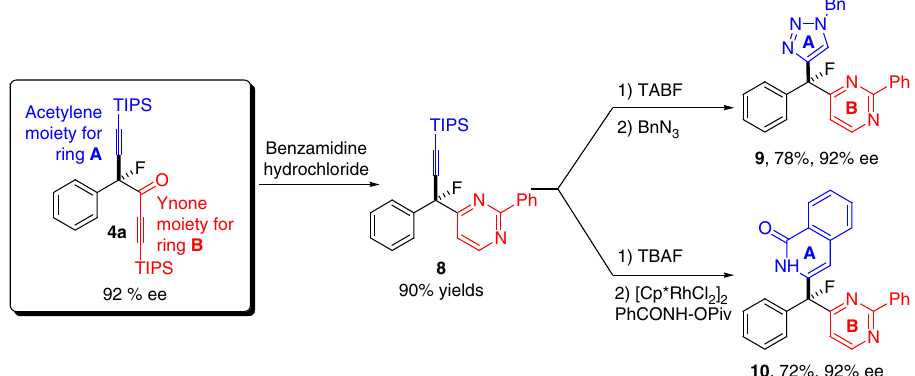
Fig. 2 Synthetic application of the α -alkynylation – α - fl uoro ynone products. Product 8 was obtained by re fl uxing 4a with benzamidine hydrochloride (1.2 eq.) in THF/water (7/1) for 16 h. Selective desilylation of 8 was accomplished using tert-butylammonium fl uoride (TBAF) in THF at 0 °C. Product 9 was obtained by click chemistry using benzyl azide and CuSO 4 and sodium ascorbate in EtOH and water. Product 10 was generated under C-H activation conditions using [Cp*RhCl 2 ] 2